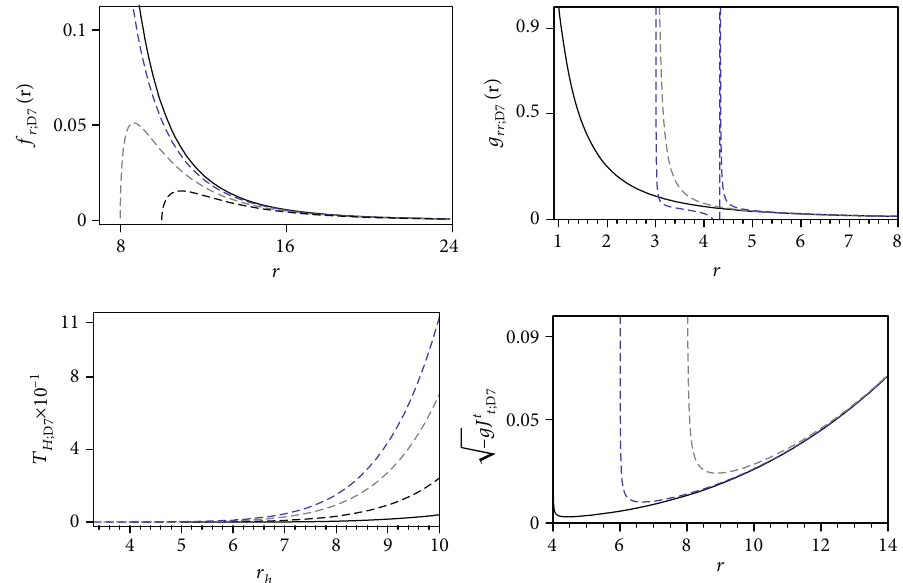
= 7 , ω = 0 (black-solid), ω = 5 0 component of the D7-brane induced rr = 3 , ω = 7 : 5 (blue-dashed) (up-right). The 0 = 5 (black-solid), r = 4 (black-dashed), 0 0